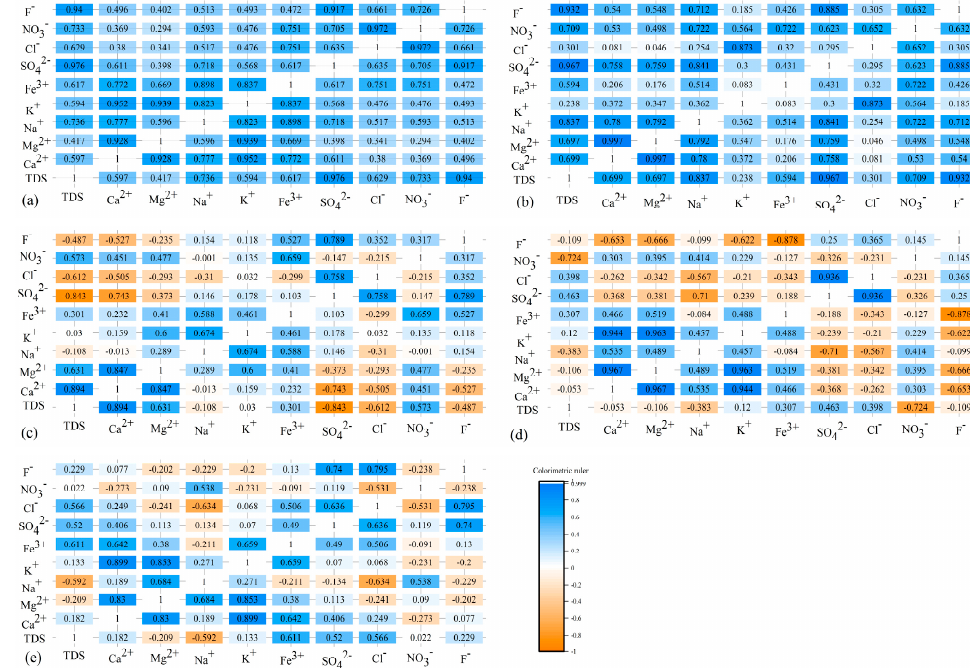
Figure 8. TDS and ions correlation plots. ( a ) TDS and ion-dependent heat map of FGU immersion solution; ( b ) TDS and ion-dependent heat map of FGLU immersion solution; ( c ) TDS and ion- dependent heat map of FGK1 immersion solution; ( d ) TDS and ion-dependent heat map of FGK2 immersion solution; ( e ) TDS and ion-dependent heat map of FGK3 immersion solution)